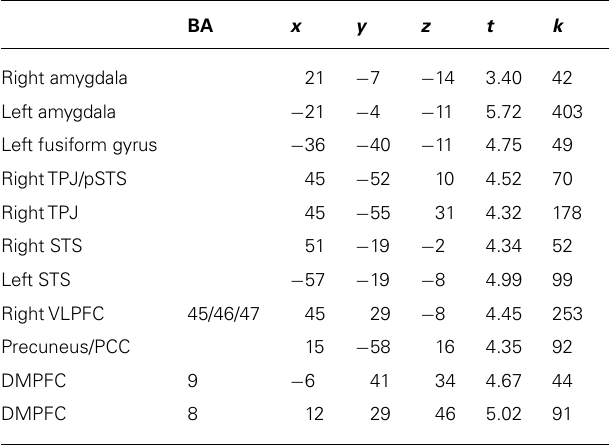
Table 3 | Neural regions activated in parents during affect labeling versus baseline that were positively associated with adolescents’ emotional